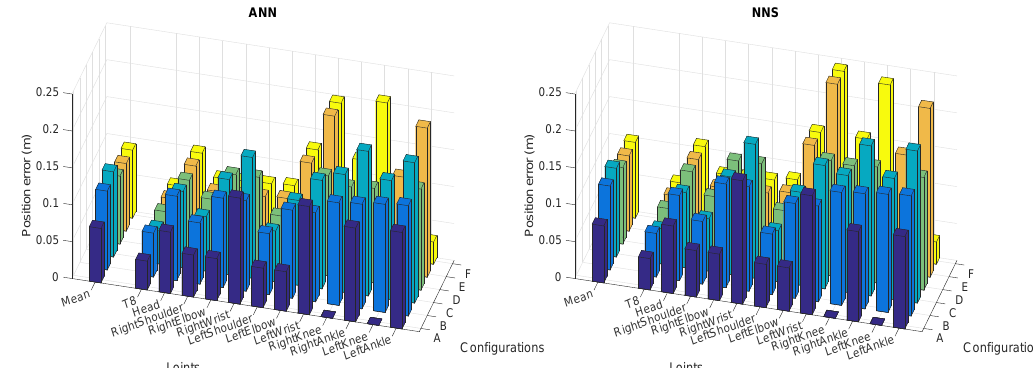
Figure 4. The left-side of both bar plots (ANN on the left and NNS on the right) shows the mean (over all six subjects) joint position error for the different configurations (as described in Figure 3). Individual mean (over all six subjects) joint position errors are shown on the right-side of both bar plots. A selection of joints is shown in both bar plots for readability. The different spine joints are not shown here because the joint position errors are comparable to the T8 joint. Additionally, the extra shoulder/foot joints are not presented because the magnitude of the error is similar to that of the shoulder and ankle joints shown.